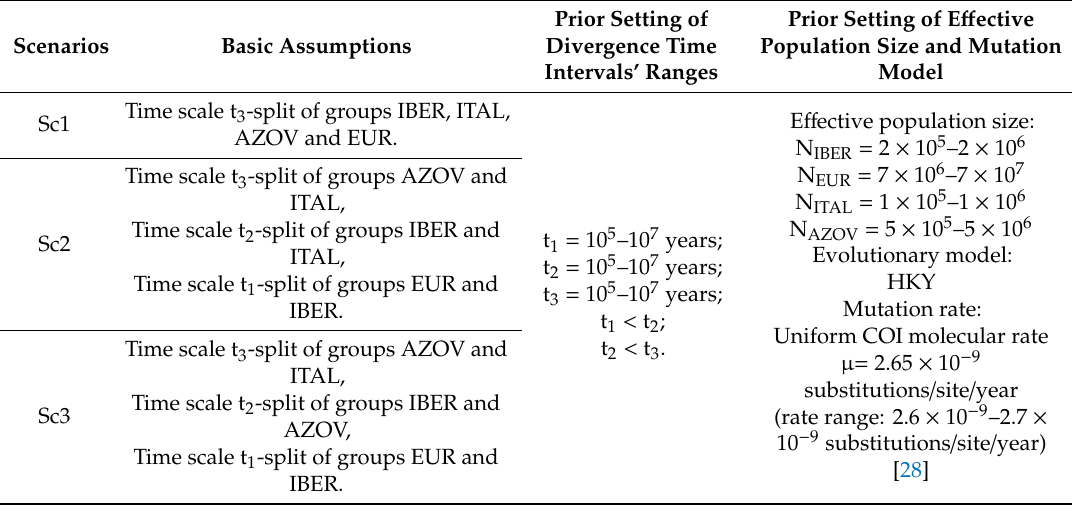
Figure 2. Demographic scenarios of Anodonta anatina lineages tested under ABC framework using COI gene sequences. All three scenarios assume that there were four populations as follows: IBER, Iberian lineage; EUR, Eurasian (recent) lineage; AZOV, Azov lineage; ITAL, Italian + Ebro lineage. In three scenarios, t # represents the time of occurrence of an event (expressed in years), and N # is the effective population size of the corresponding populations during each time period. Time scale shown on the right. Prior settings presented in Table 1. Table 1. Prior assumptions and settings of three biogeographical scenarios, which were tested under an ABC framework.